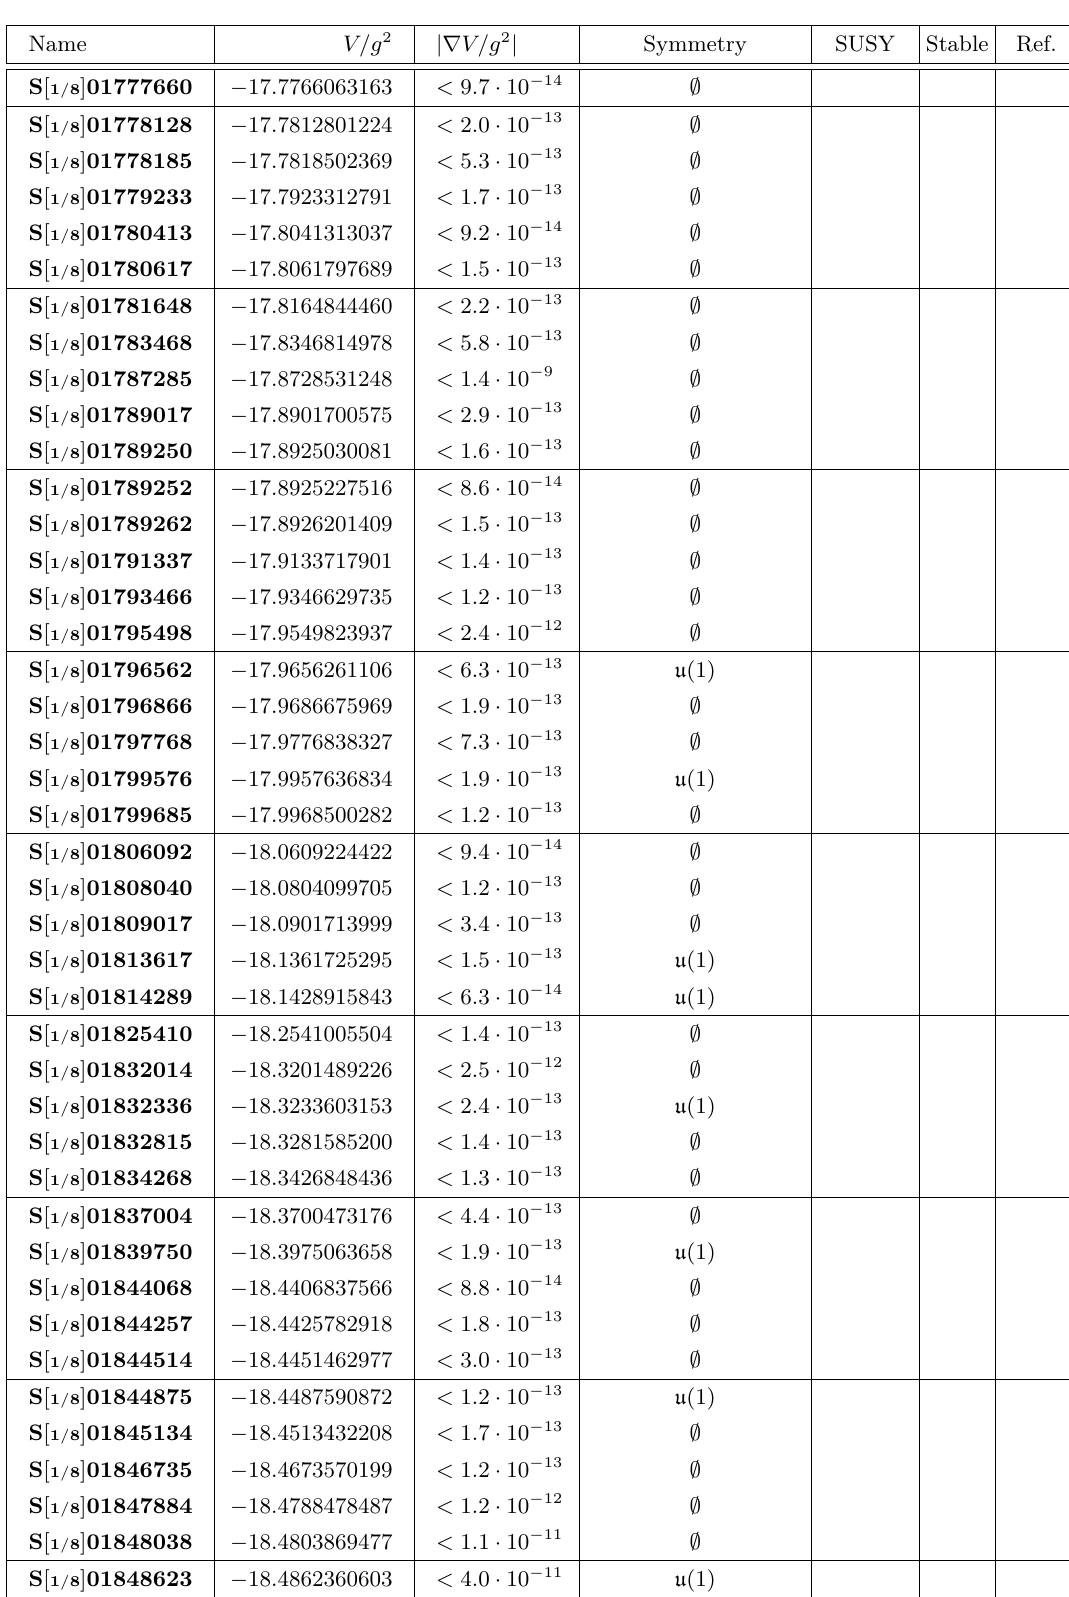
Table 1. Summary of vacua at ω = π/ 8